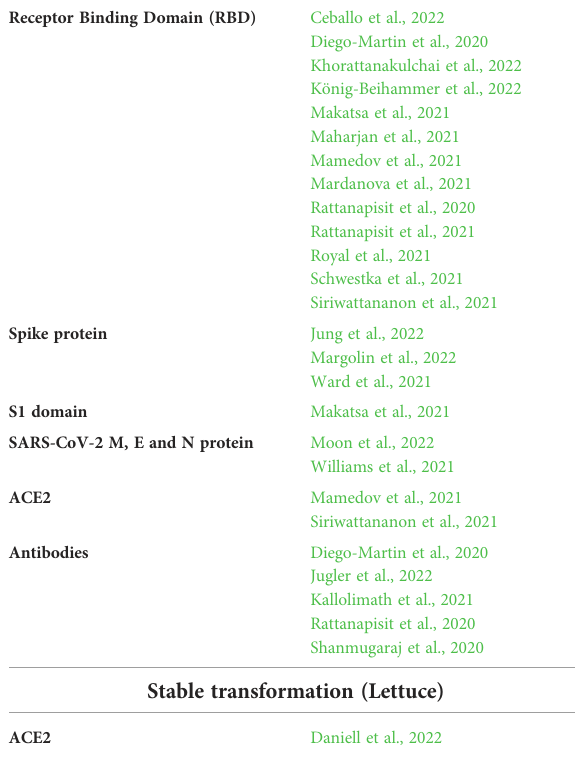
TABLE 1 Reported Plant-made COVID-19 related proteins (March 2020 to July